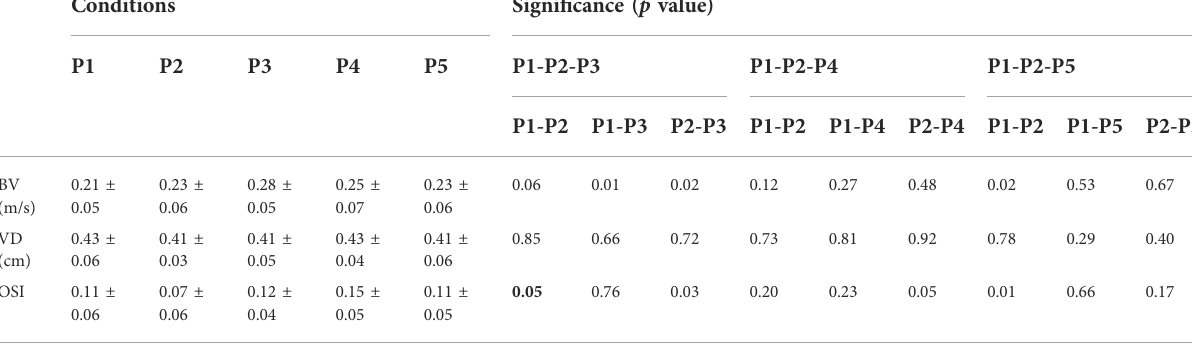
TABLE 2 Effects of different intervention programs on other hemodynamic parameters.